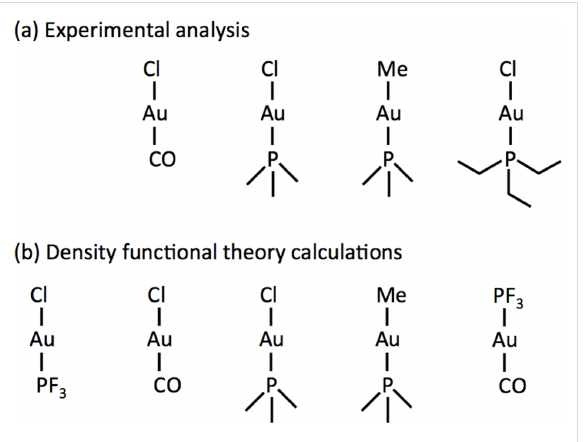
Figure 2: The Au(I) precursors that were studied (a) experimentally and (b) using density functional theory